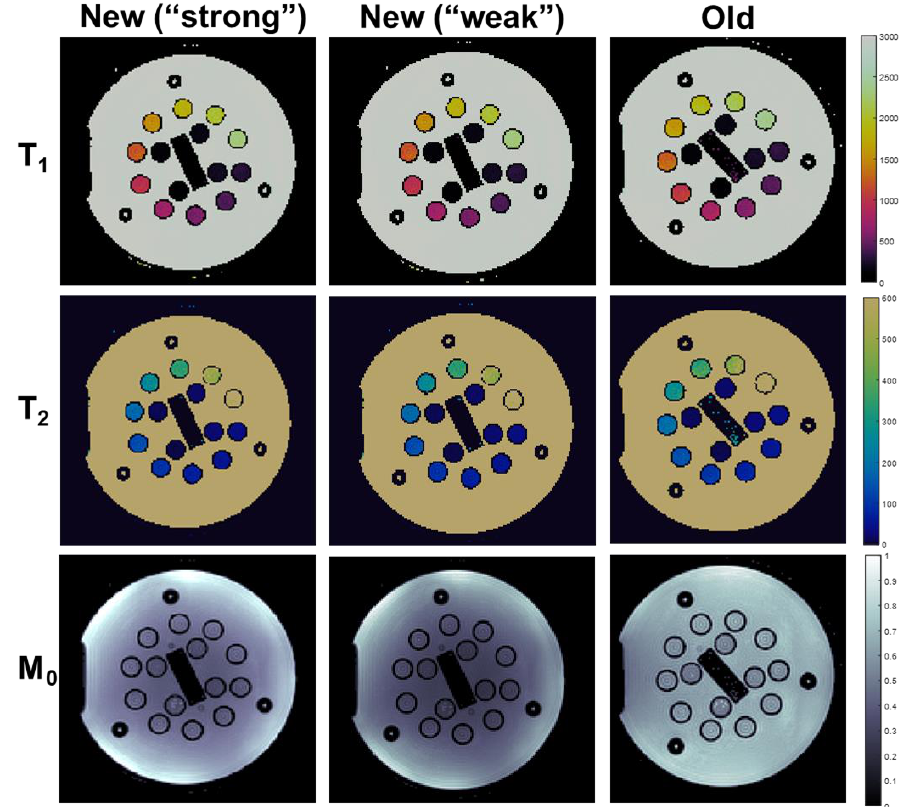
Figure 2. MRF maps of the ISMRM/NIST quantitative imaging phantom from the new scanner with the standard MRF spiral trajectory (‘strong’ gradients), the new scanner with the modified spiral trajectory (‘weak’ gradients), and the old scanner with the modified (‘weak’) spiral trajectory. T 1 and T 2 maps show comparable quality without large differences in reference object relaxometry values. M 0 maps obtained from the two scanners have differing appearance potentially due to differences in receive coil sensitivities.